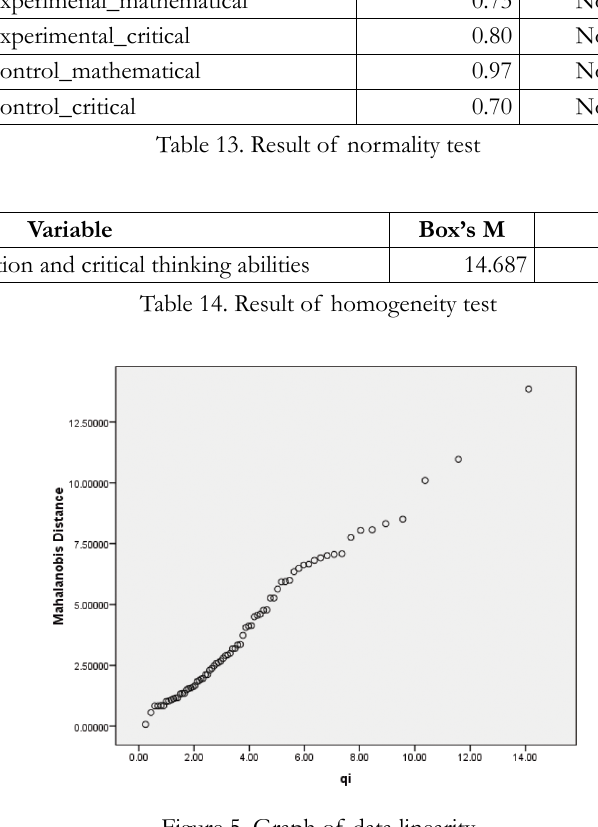
Figure 5. Graph of data